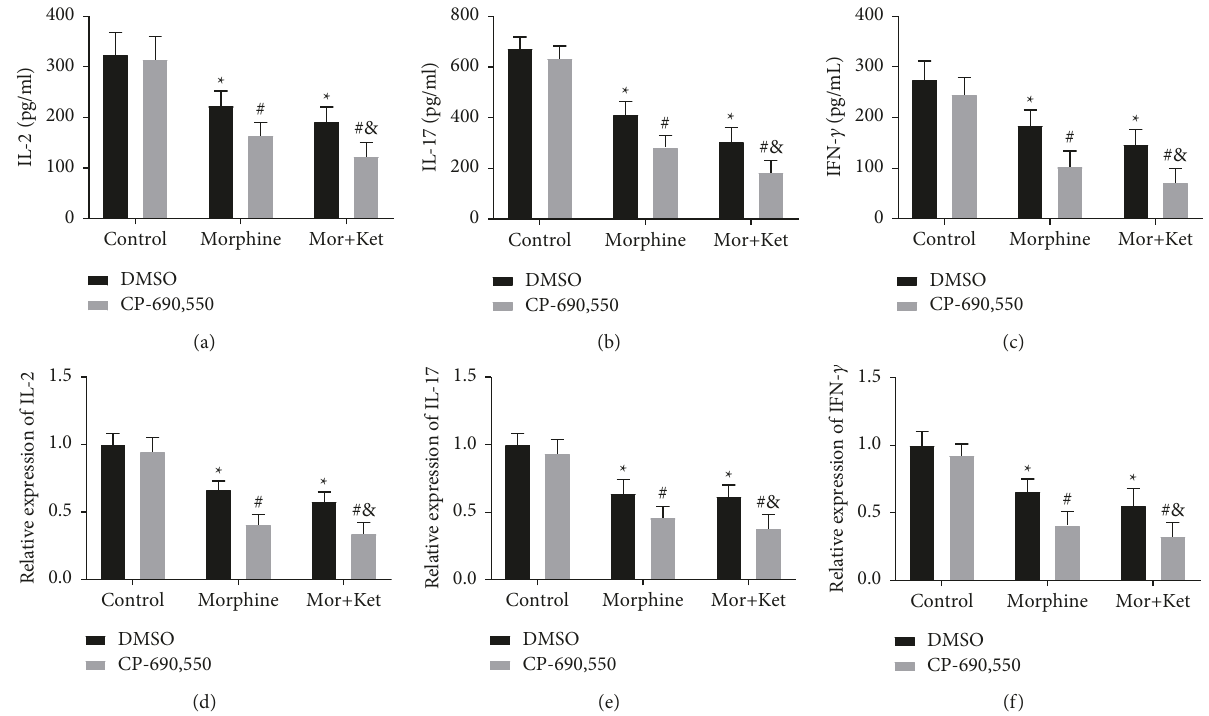
Figure 6: Morphine and ketamine restrain the levels of IL-2, IFN- c , and IL-17 via the JAK3/STAT5 pathway in vitro. (a) The level of IL-2 after CP-690,550 treatment measured by ELISA. (b) The level of IL-17 after CP-690,550 treatment measured by ELISA. (c) The level of IFN- c after CP-690,550 treatment measured by ELISA. (d) The mRNA expression of IL-2 after CP-690,550 treatment detected by qRT-PCR. (e) The mRNA expression of IL-17 after CP-690,550 treatment detected by qRT-PCR. (f) The mRNA expression of IFN- c after CP-690,550 treatment detected by qRT-PCR. ∗ P < 0 . 05 vs. the control (DMSO) group. # P < 0 . 05 vs. the control (CP-690,550) group. & P < 0 . 05 vs. the Mor+ Ket (DMSO)